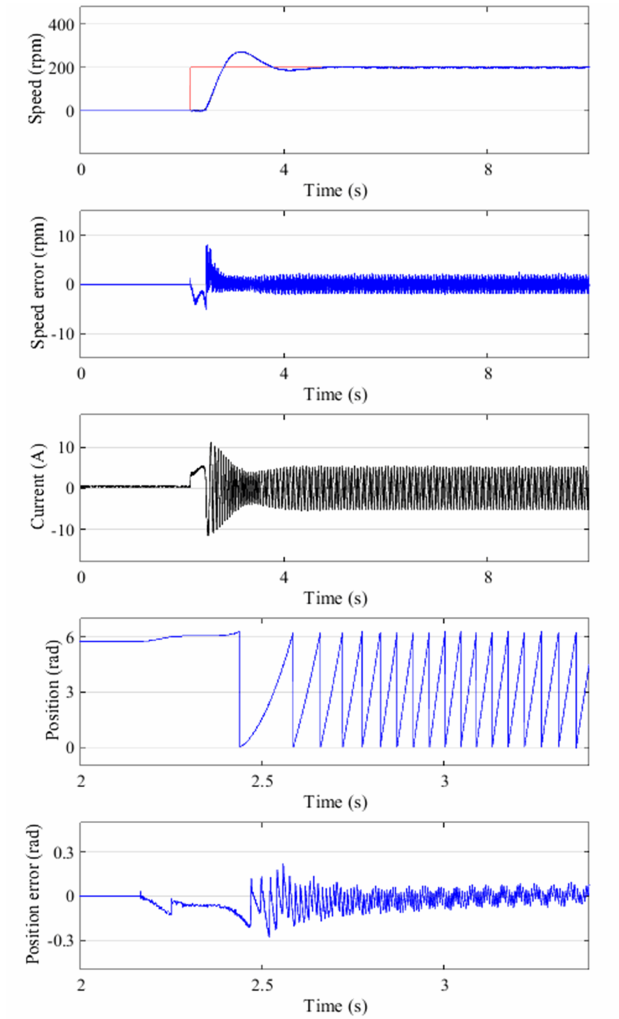
Figure 9. The motor starts up from zero speed to 200 rpm (0.1